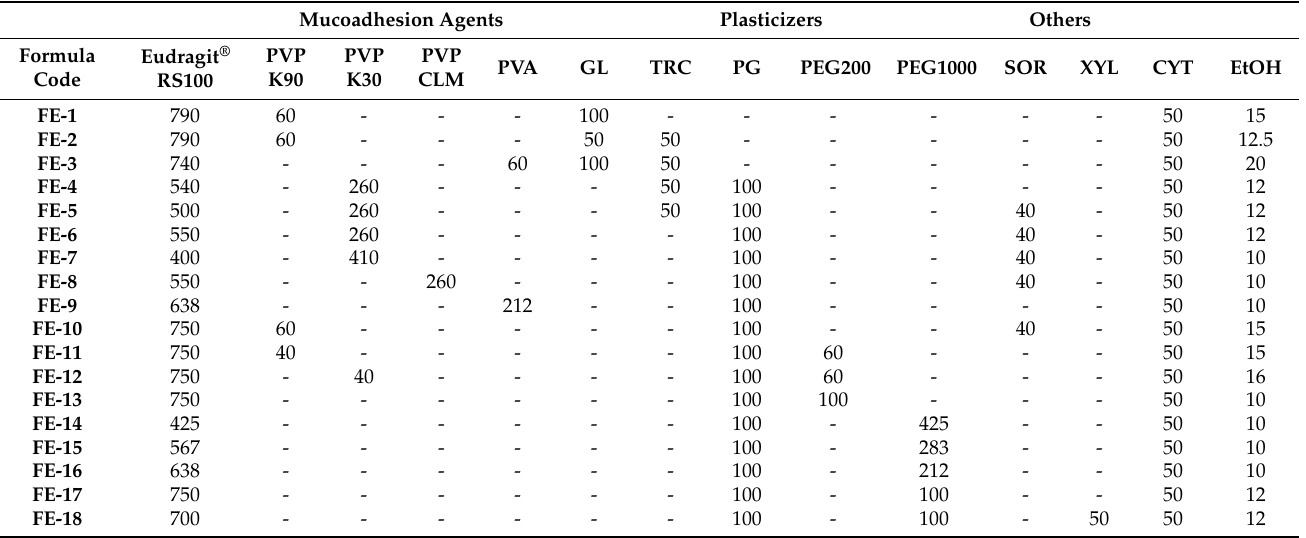
Table 1. Weight composition (mg) of CYT-loaded buccal films prepared by solvent casting method by using ethanol (mL) as